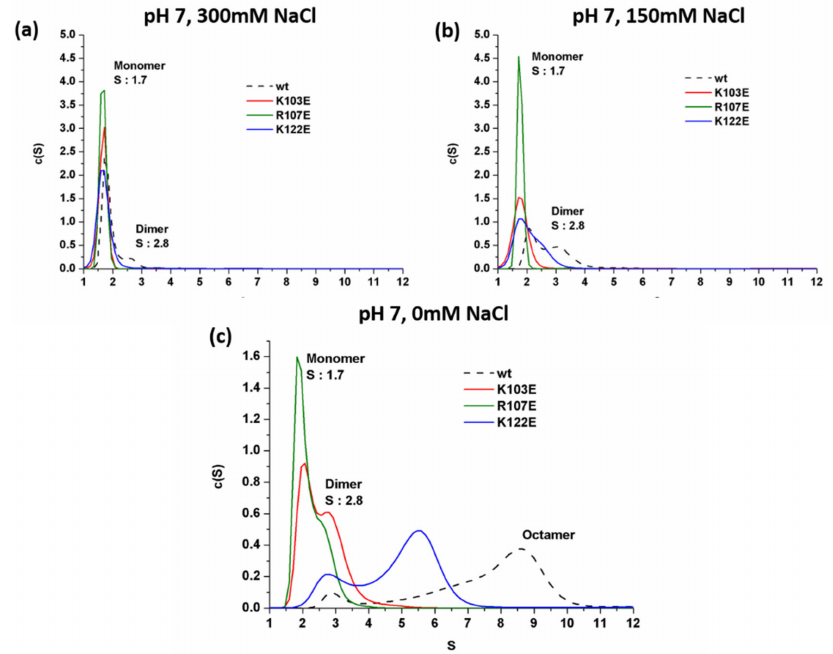
Figure 7. Overlay of sedimentation profiles of WT AcSpN, K103E, R107E, and K122E mutants at pH